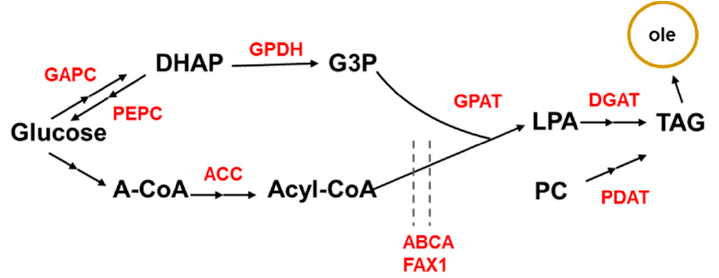
Figure 2. Schematic representation of the TAG biosynthetic pathway in plants. (GAPC, glyceraldehyde-3-phosphate dehydrogenase; PEPC, phosphoenolpyruvate carboxylase; DHAP, dihydroxyacetone phosphate; GPDH, Glycerol-3-phosphate dehydrogenase; G3P, glycerol-3-phosphate; A-CoA, acetyl-CoA; ACC, acetyl-CoA carboxylase; GPAT, glycerol-3-phosphate acyltransferase; LPA, lysophosphatidic acid; DGAT, diacylglycerol acyltransferase; PC, phatidylcholine; PDAT, phospholipid diacylglycerol acyltransferase; TAG, triacylglycerol). Dash lines represent transmembrane transport.